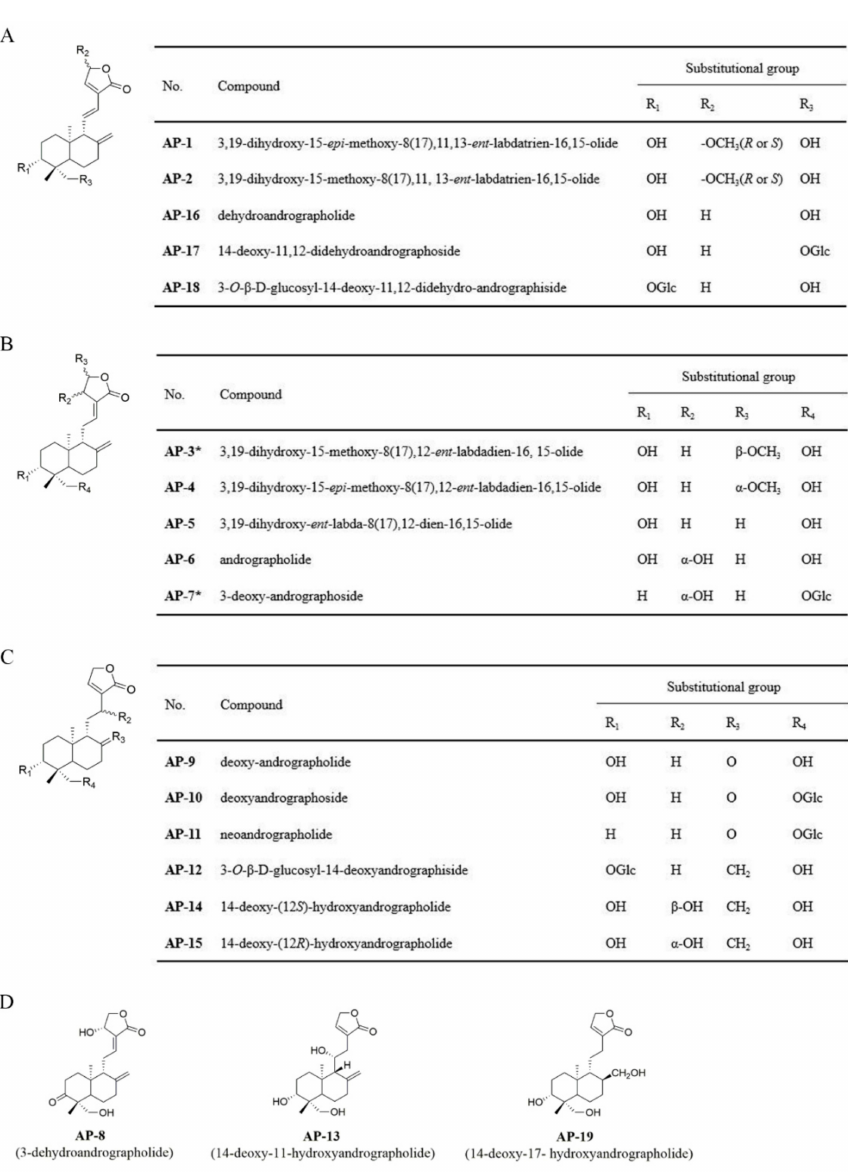
Figure 1. The chemical structures of 19 diterpenoid lactones (* compounds: